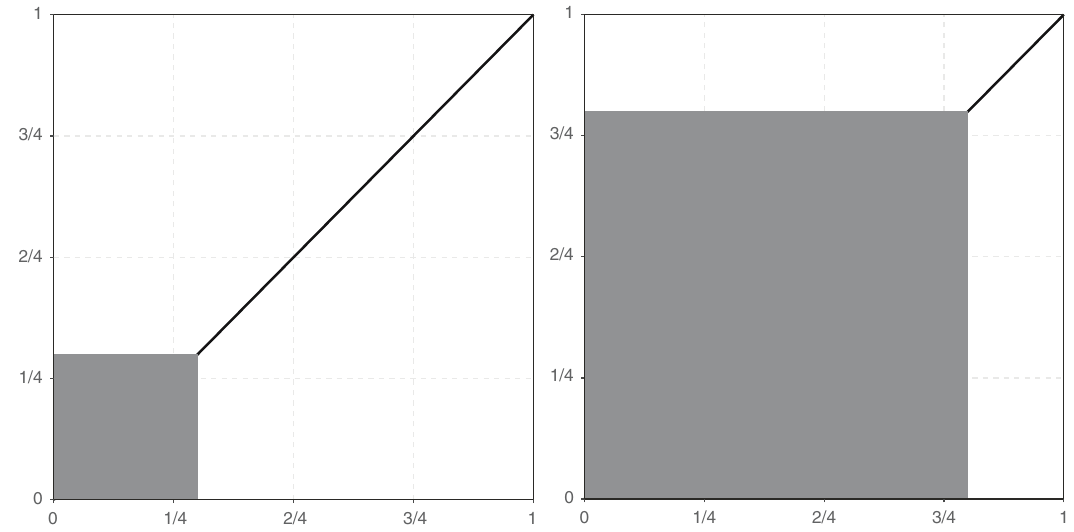
Figure 1: Mass distribution of the doubly stochastic measure μ